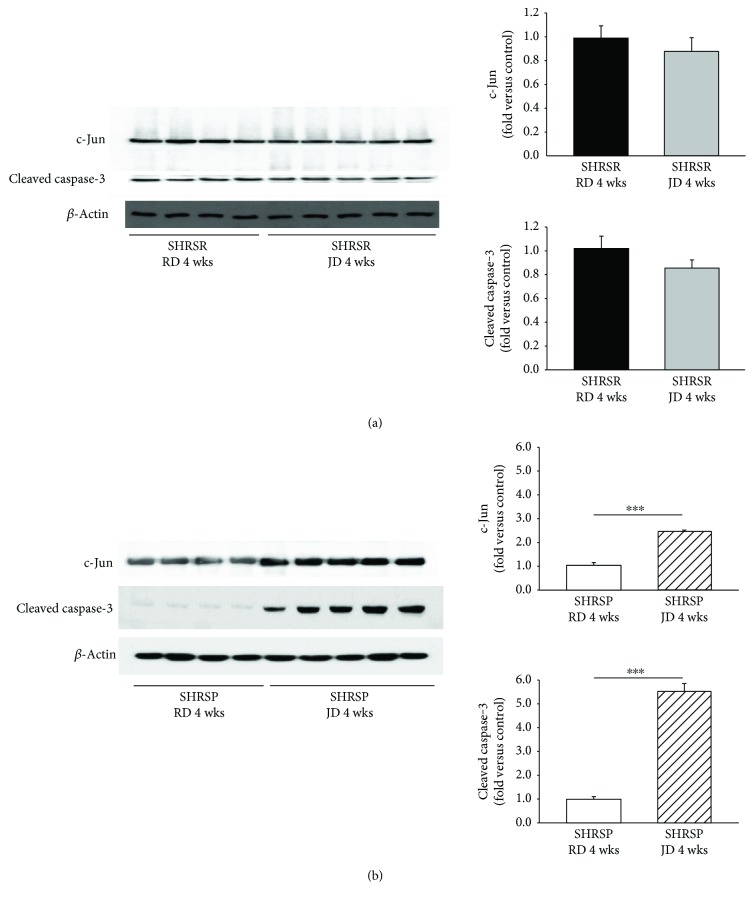
Characterization of brain expression level of cleaved caspase-3 and c-Jun in JD- versus RD-fed SHRSR and SHRSP strains. (a) Representative Western blots with corresponding densitometric analysis are shown for c-Jun and cleaved caspase-3 in the brains of RD- and JD-fed SHRSR. (b) Representative Western blots with corresponding densitometric analysis are shown for c-Jun and cleaved caspase-3 in the brains of RD- and JD-fed SHRSP. ∗∗∗p < 0.0001 JD- versus RD-fed SHRSP. JD = high-salt Japanese style diet; RD = regular diet. N = 8 for each experimental group.